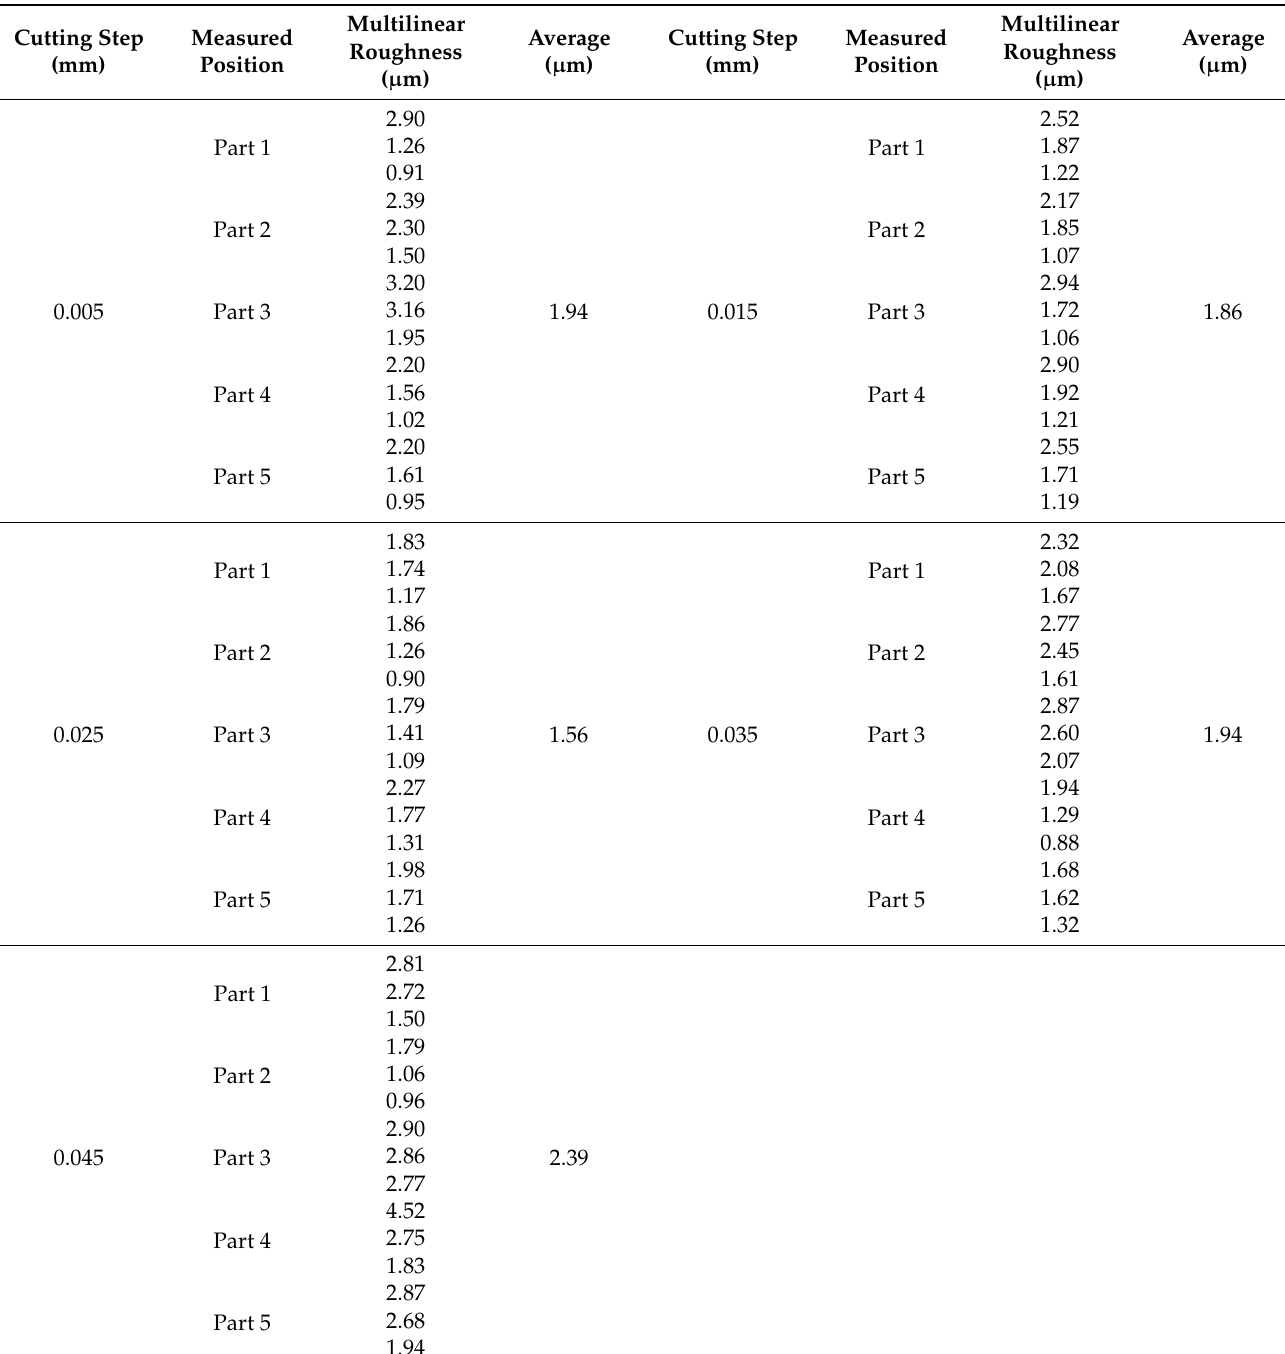
Table 4. Measured multilinear roughness (Ra) for each cutting